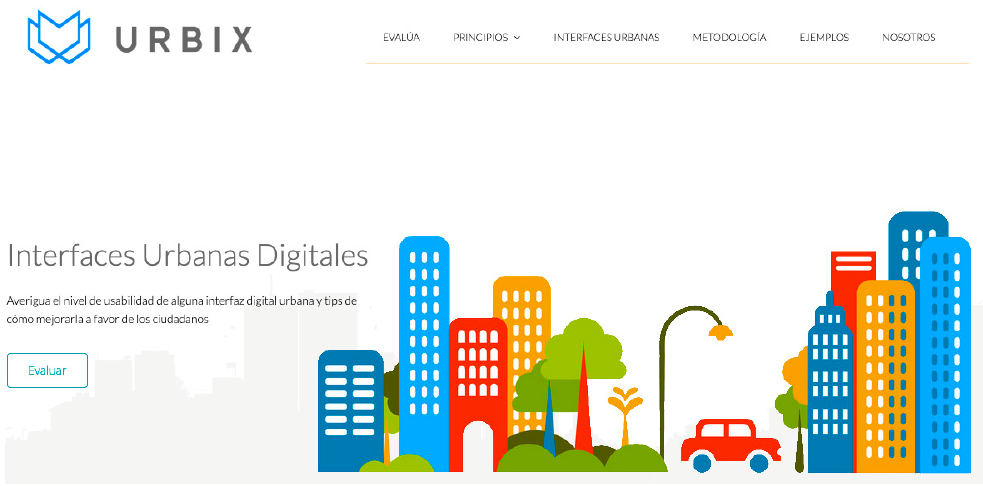
Figure 12. Screenshot of Reframer by Optimal Workshop, a web-based tool used to capture the field notes of each observation.